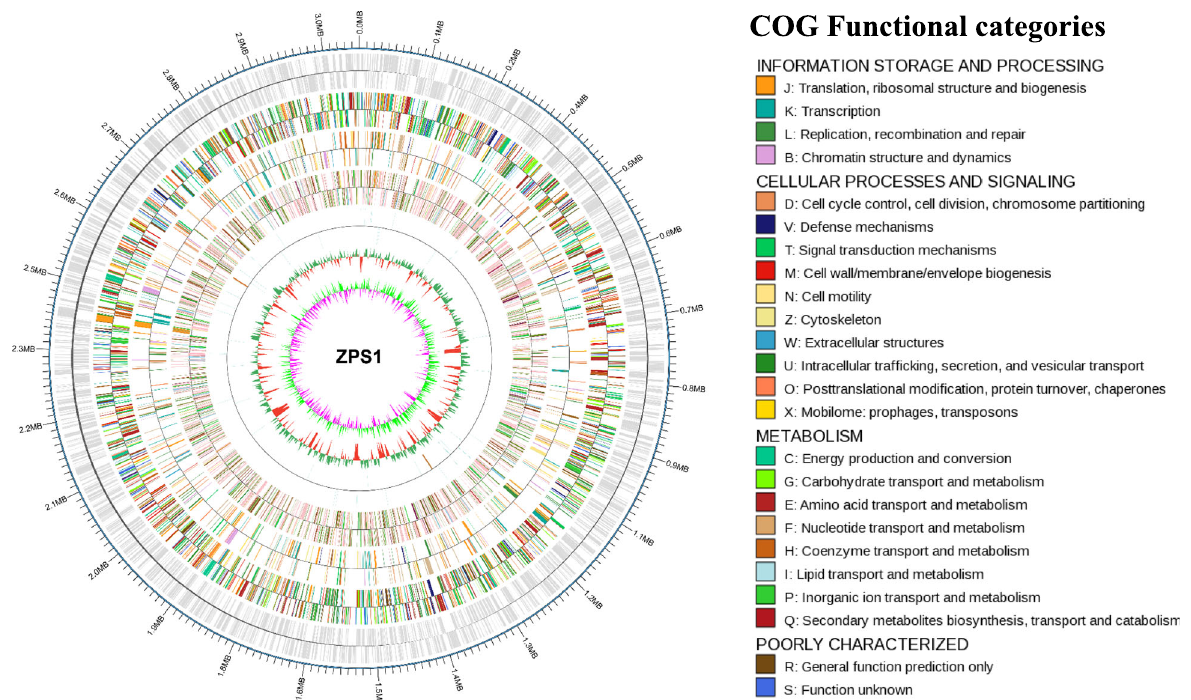
Fig. 2 Genome map of Halomicrobium sp. ZPS1. From the outer cycle to the inner cycle, circle 1 indicates the total base pairs and the position coordinates of the genomic sequence; circle 2 shows the coding genes; circles 3, 4, and 5 represent the gene functional annotation results colored according to COG, KEGG, and GO, respectively; circle 6 shows the ncRNAs; circle 7 indicates the genomic GC content; and circle 8 illustrates the genomic GC skew value distribution